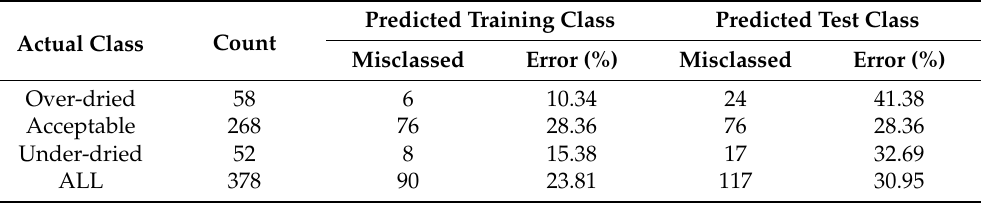
Table 9. Summary of misclassification and error for random forest